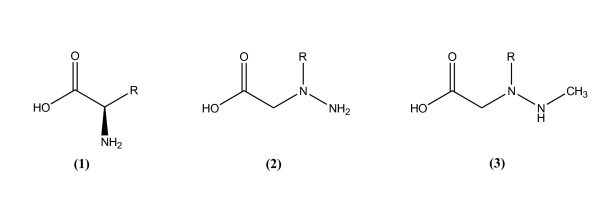
l-amino acid (1), its aza-β3-analog (2) and Nβ-methyl-aza-β3-analog (3).